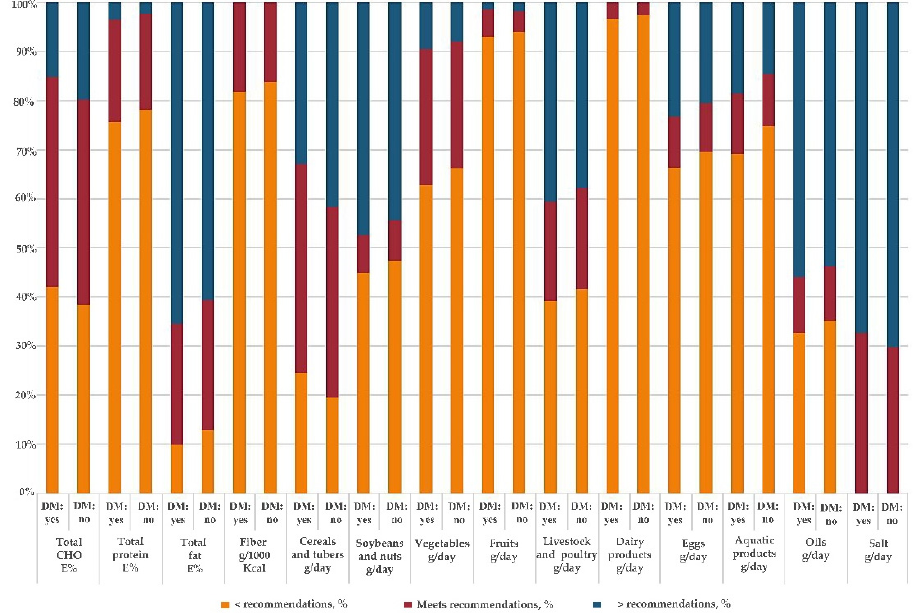
Figure 2. Percentage of adults with diabetes complying with the dietary recommendations